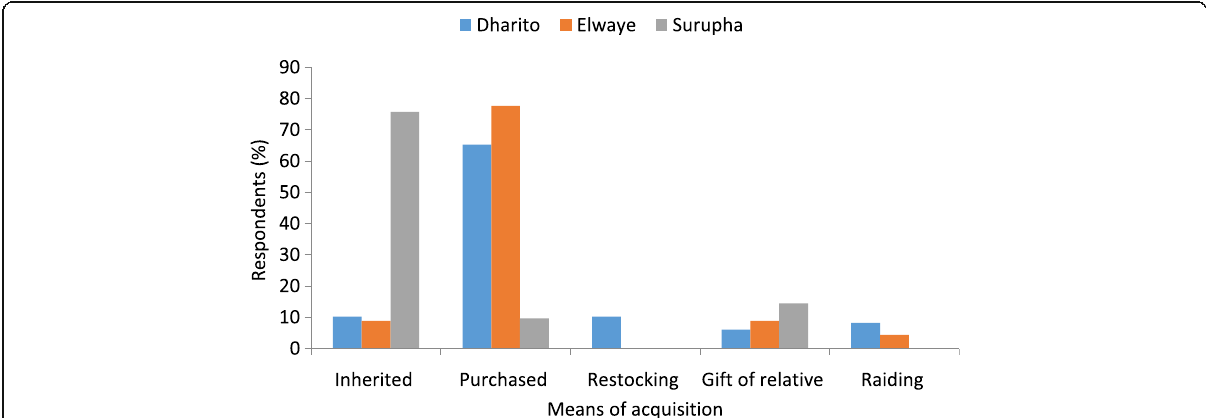
Fig. 5 Perceptions of pastoralists (%) regarding means of camel acquisition between the Gada period of Jilo Aga and Guyo Goba in the three kebeles in the study area in Borana, southern Ethiopia